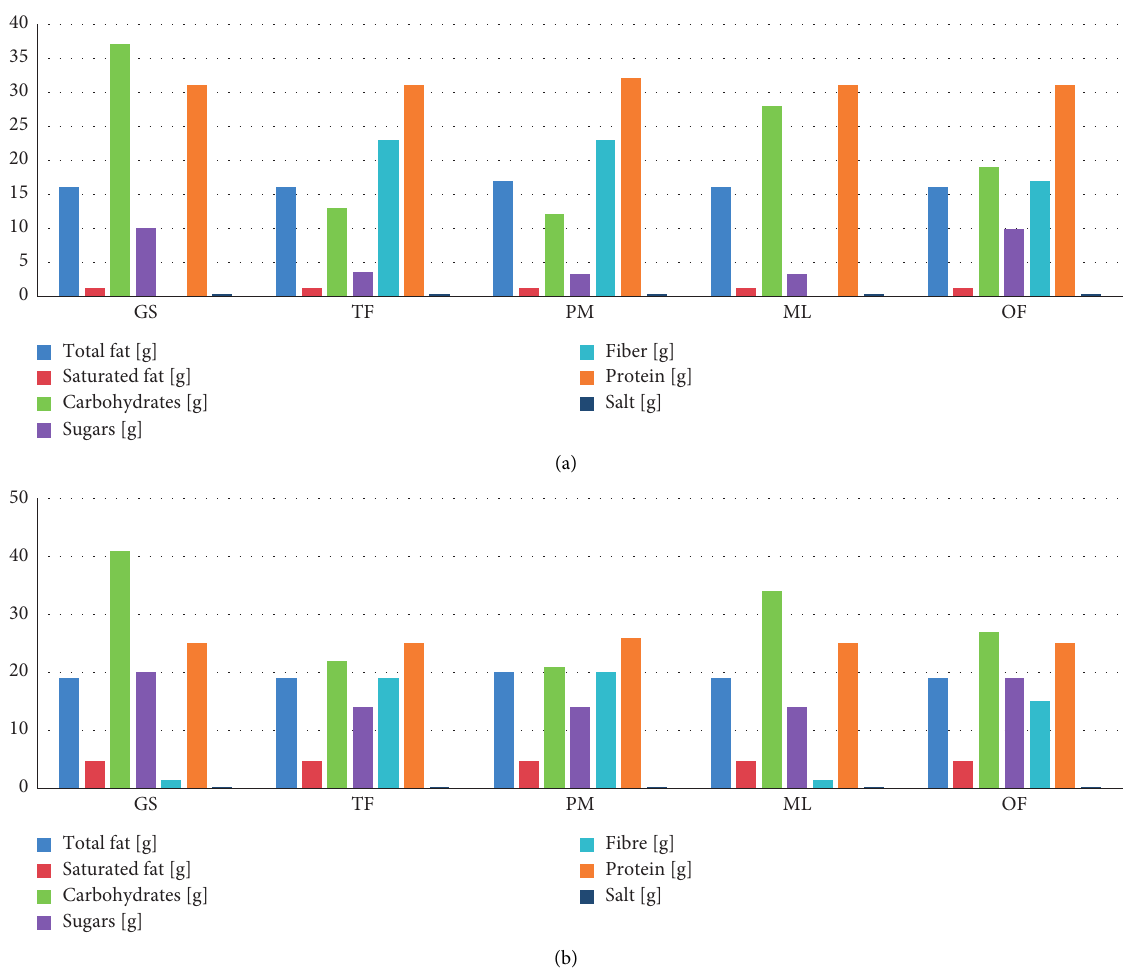
Figure 4: (a) Nutritional value of high-protein bars without chocolate covering; (b) with chocolate covering. OF oligofructose, TF—tapioca liquid fiber, ML—maltitol, PM—chickpea-maize liquid fiber.